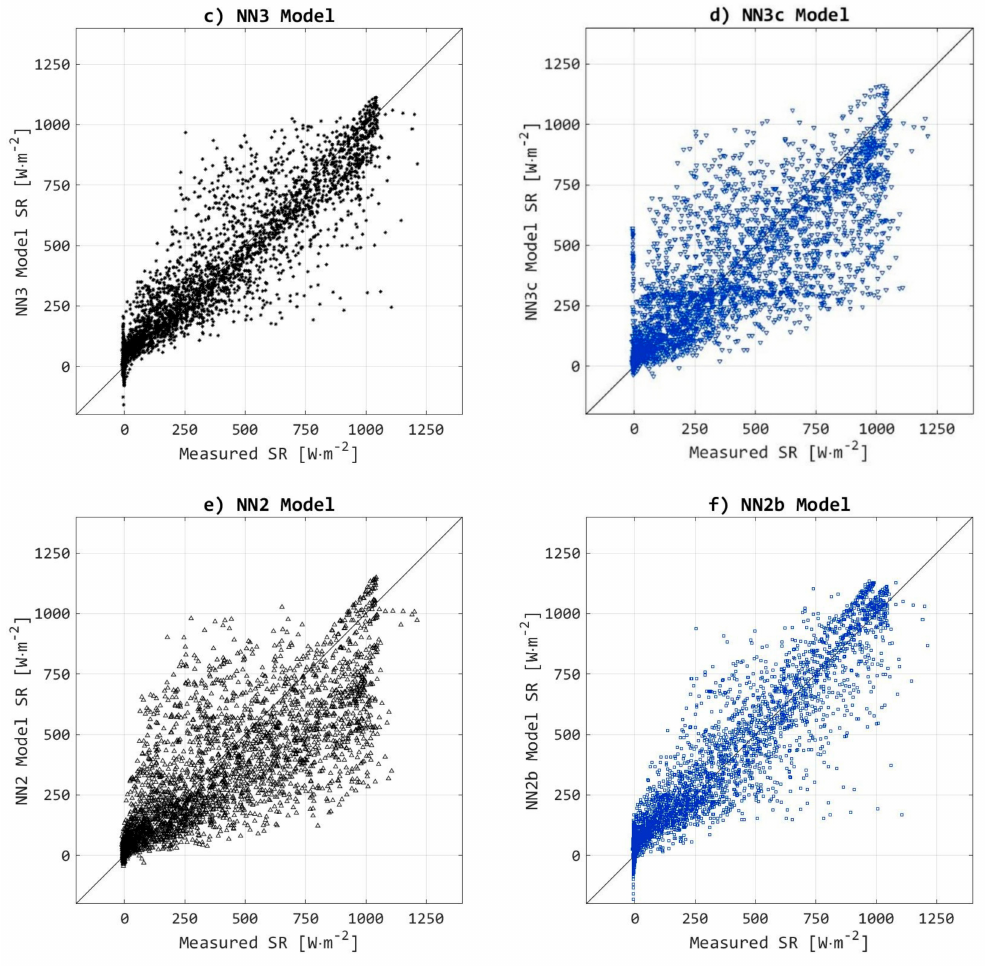
Figure 2. Comparison of the six NN models ( a – f , respectively) to measured downwelling shortwave radiation during 2015